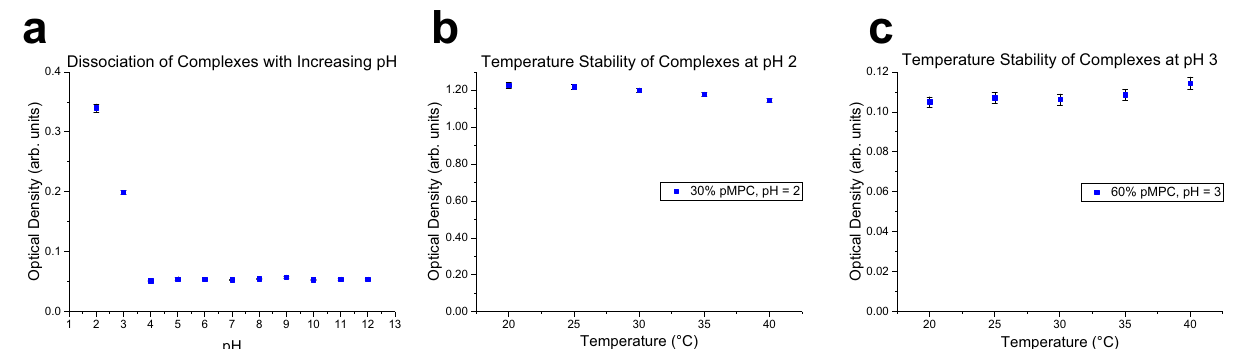
Fig. 8 Effects of pH and temperature on pZC assembly. a Scattered light intensity as a function of solution pH of 50:50 stoichiometric ratio pMPC:pAA. b At pH 2, in samples with a 30:70 stoichiometric ratio (corresponding to the peak), heating over a temperature ranging from 20 – 40 ∘ C causes negligible changes in coacervate turbidity, demonstrating stability of pMPC:pAA complexes with respect to temperature. c Peak samples at pH 3 (60:40 pMPC:pAA stoichiometric ratio) exhibit a similar resistance against thermal fl uctuations over the same 20 – 40 ∘ C range. Error bars represent the standard deviation between measurements.